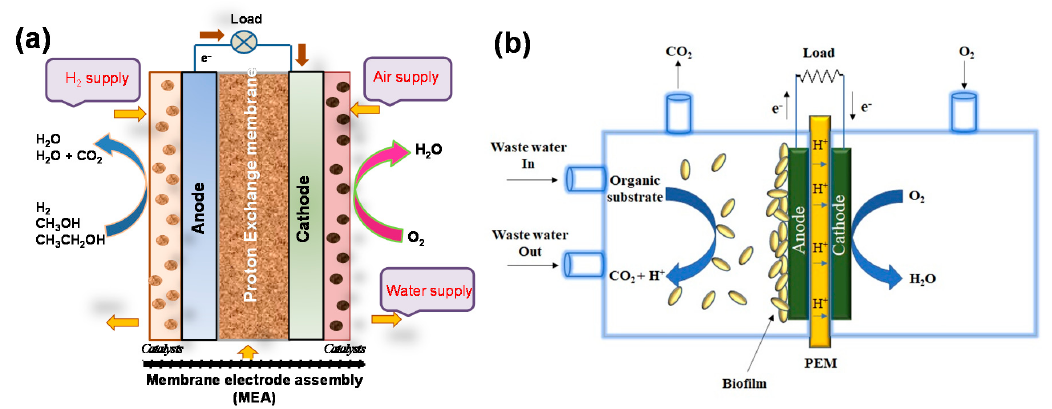
Figure 2. Schematic illustration of the working principle in ( a ) direct alcohol fuel cells and ( b ) microbial fuel cells.